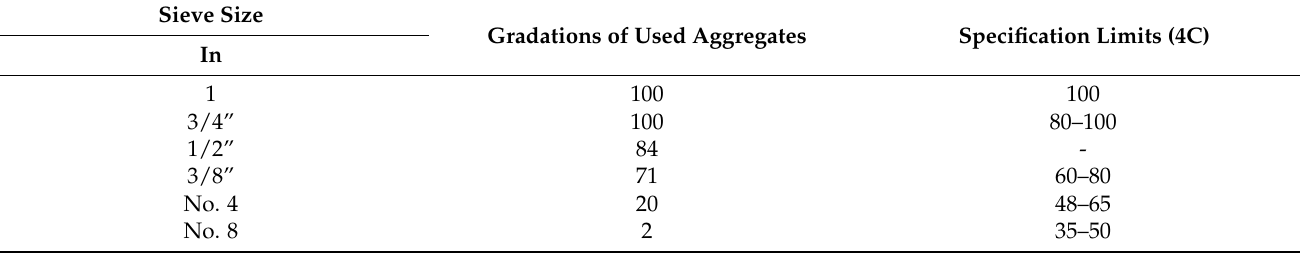
Table 8. Aggregate gradation of subbase layer.